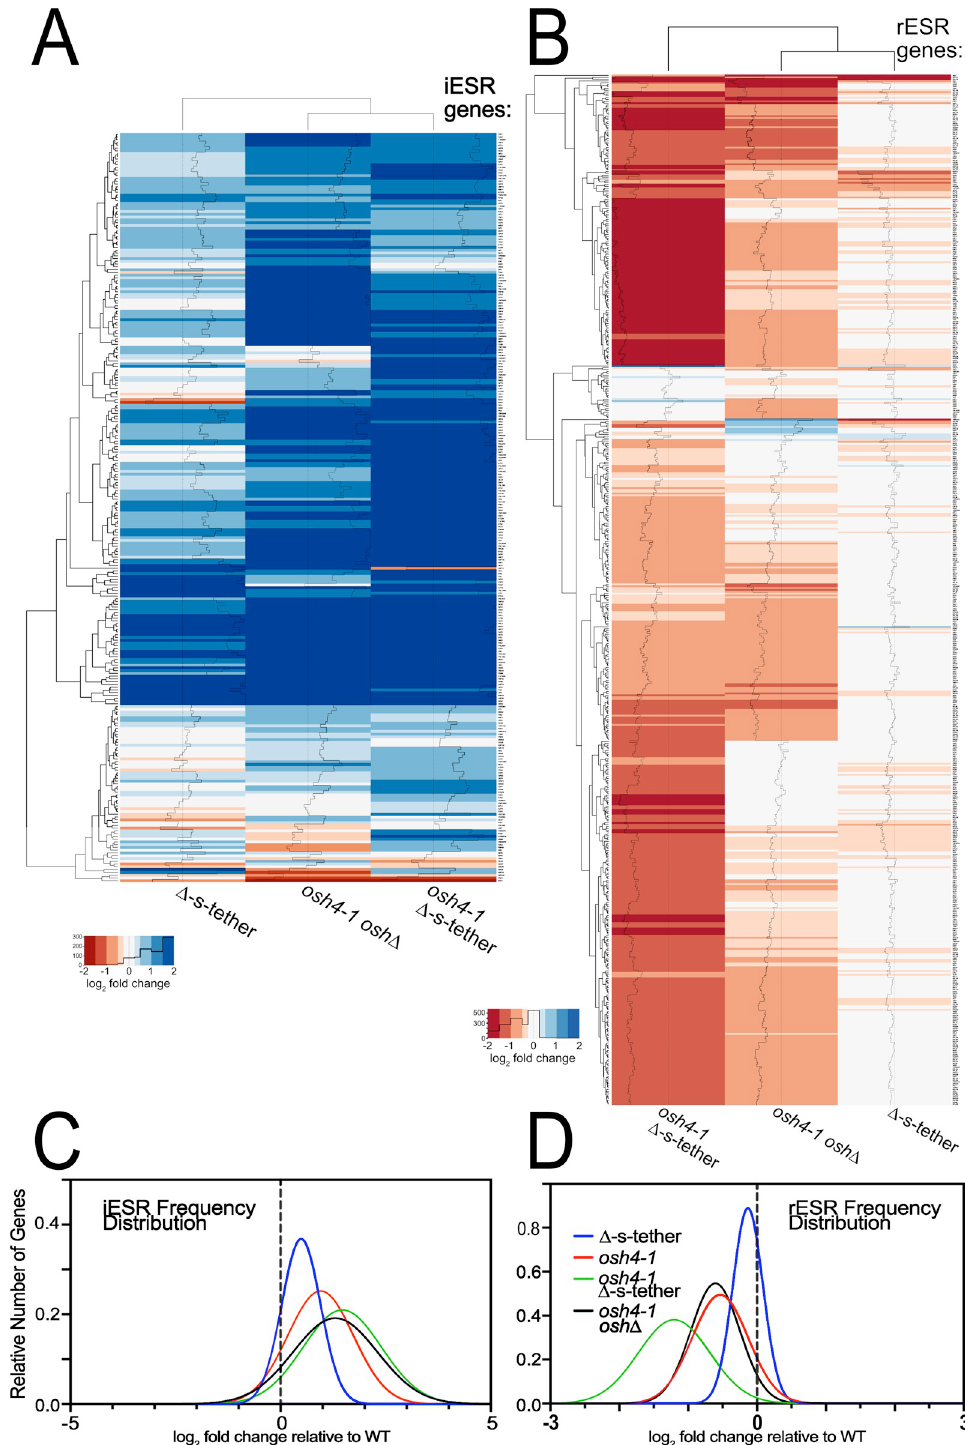
Fig 6. ESR responses to OSH and ER-PM tether mutations. Heatmap analyses of transcriptional responses relative to WT (SEY6210) at 37˚C for 1 h in osh4-1 ts Δ -s-tether (CBY6031), Δ -s-tether (CBY5898), and osh4-1 ts osh Δ (CBY926) cells affecting (A) iESR and ( B) rESR genes. Downregulated genes are shown in red, upregulated genes are shown in blue. iESR and rESR regulated genes were curated from previous reports [51,87]. Histograms within each column represents the number of transcripts for each color in the heatmap. (C) Graphical representations of the distribution of iESR and (D) rESR gene responses in osh4-1 ts Δ -s-tether, Δ -s-tether, and osh4-1 ts osh Δ cells. https://doi.org/10.1371/journal.pgen.1010106.g006 PLOS Genetics | https://doi.org/10.1371/journal.pgen.1010106 March 3,